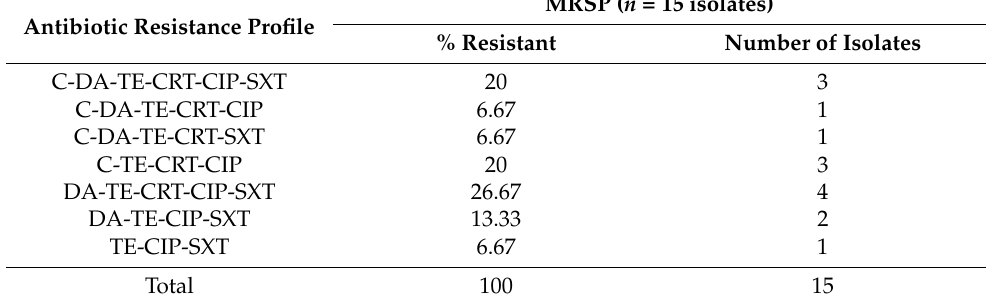
Antibiotic Resistance Profile C-DA-TE-CRT-CIP-SXT